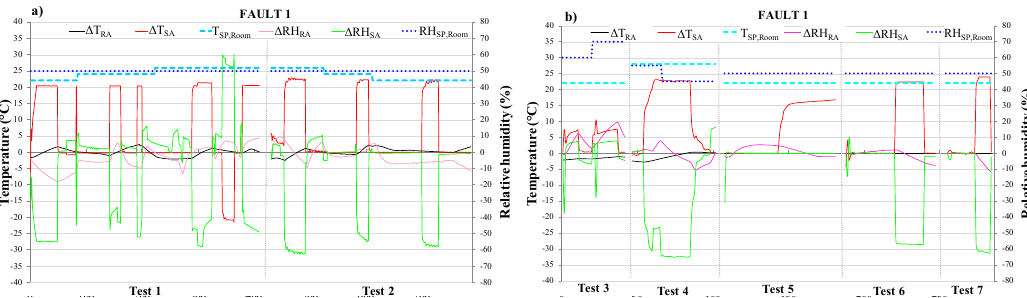
Figure 7. Comparison between normal operation and operation with fault 1: test 1, 2 ( a ), test 3, 4, 5, 6, 7 ( b ).